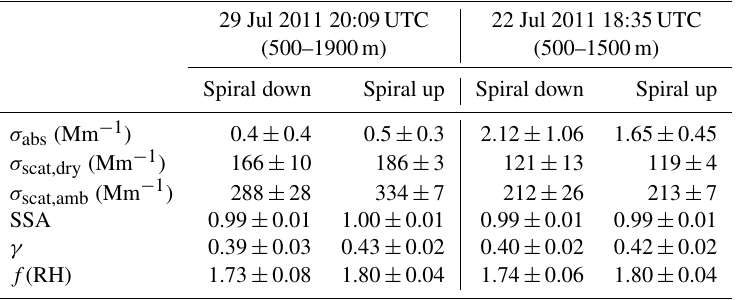
Table 2. Mean values in the planetary boundary layers of hygroscopicity parameters γ and f (RH), absorption ( σ abs,dry ) and scattering ( σ scat,dry ) coefficients and single scattering albedo (SSA) for dry conditions, and scattering coefficient for ambient conditions ( σ scat,amb ). Reference wavelength for all aerosol optical parameters is 532nm.